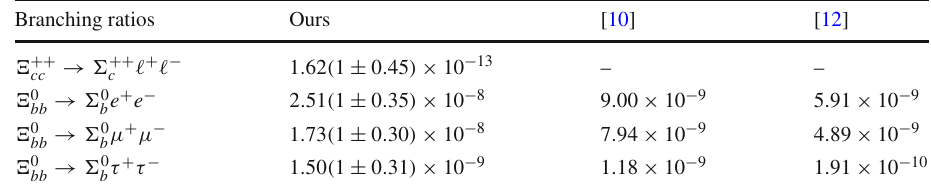
Branching ratios